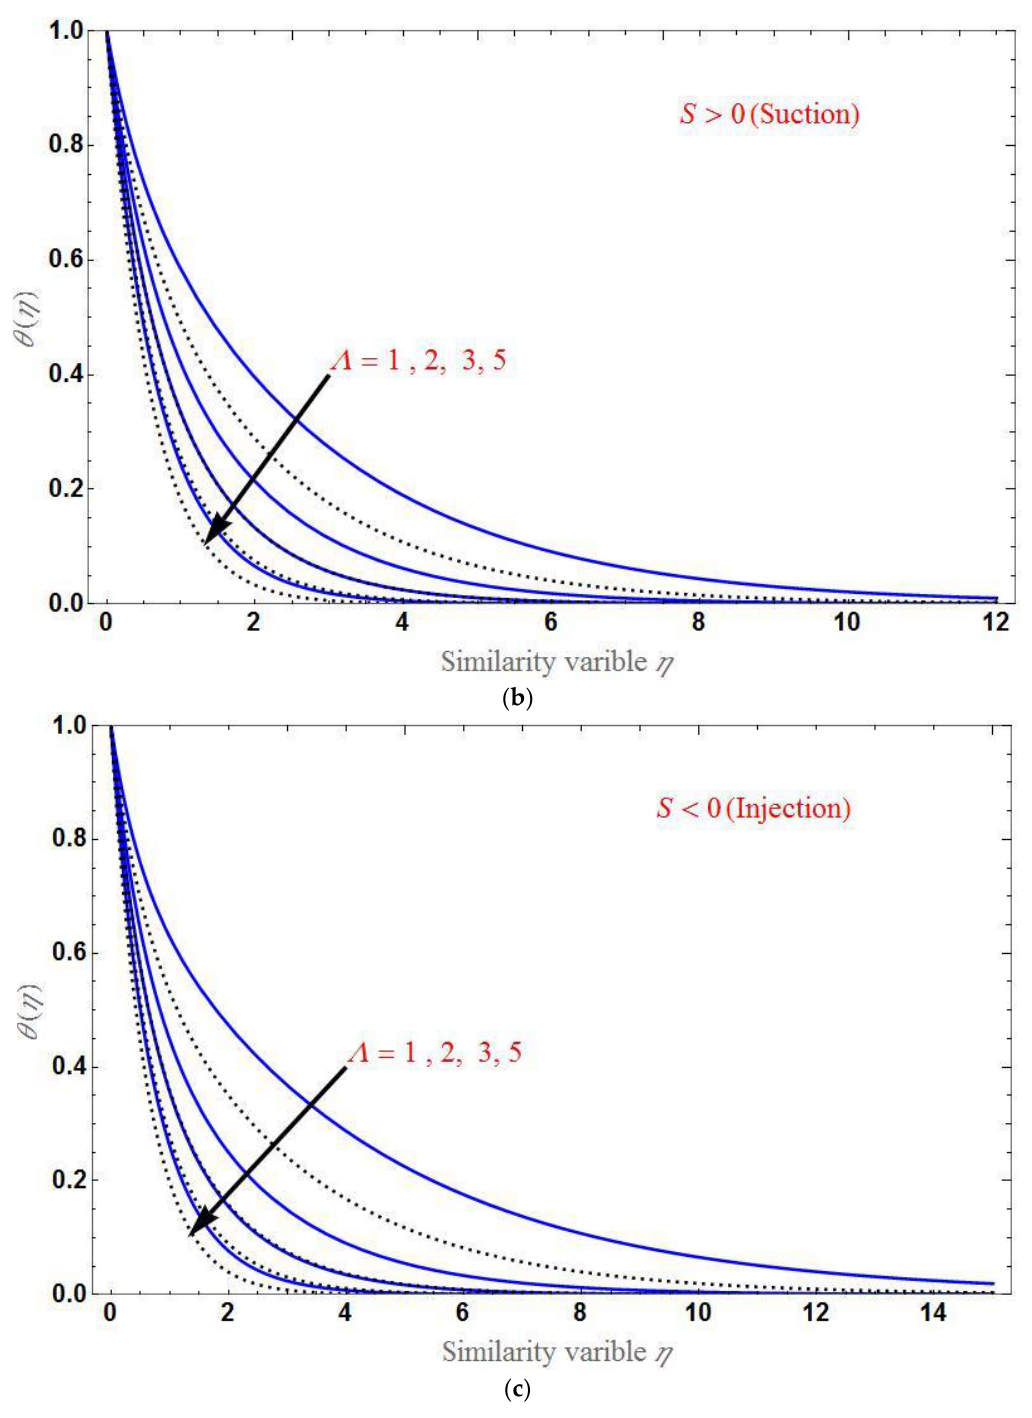
Figure 7. The temperature distribution θ ( η ) as a function of η for various values of Λ and for three different regimes of S : ( a ) S = 0, ( b ) S = 1 and ( c ) S = −1 . The other fixed parameters are: M = Da − 1 = N R = 1, φ 1 = 0.1, φ 2 =